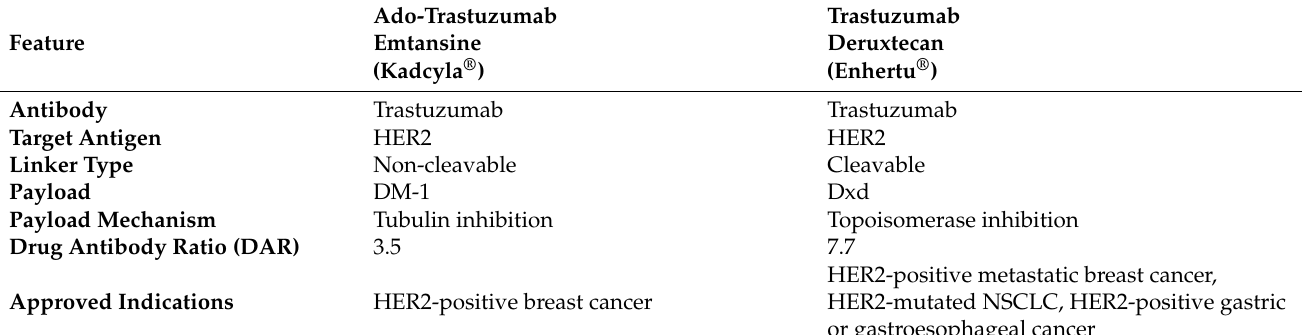
Table 3. Comparative features of Enhertu ® and Kadcyla ®